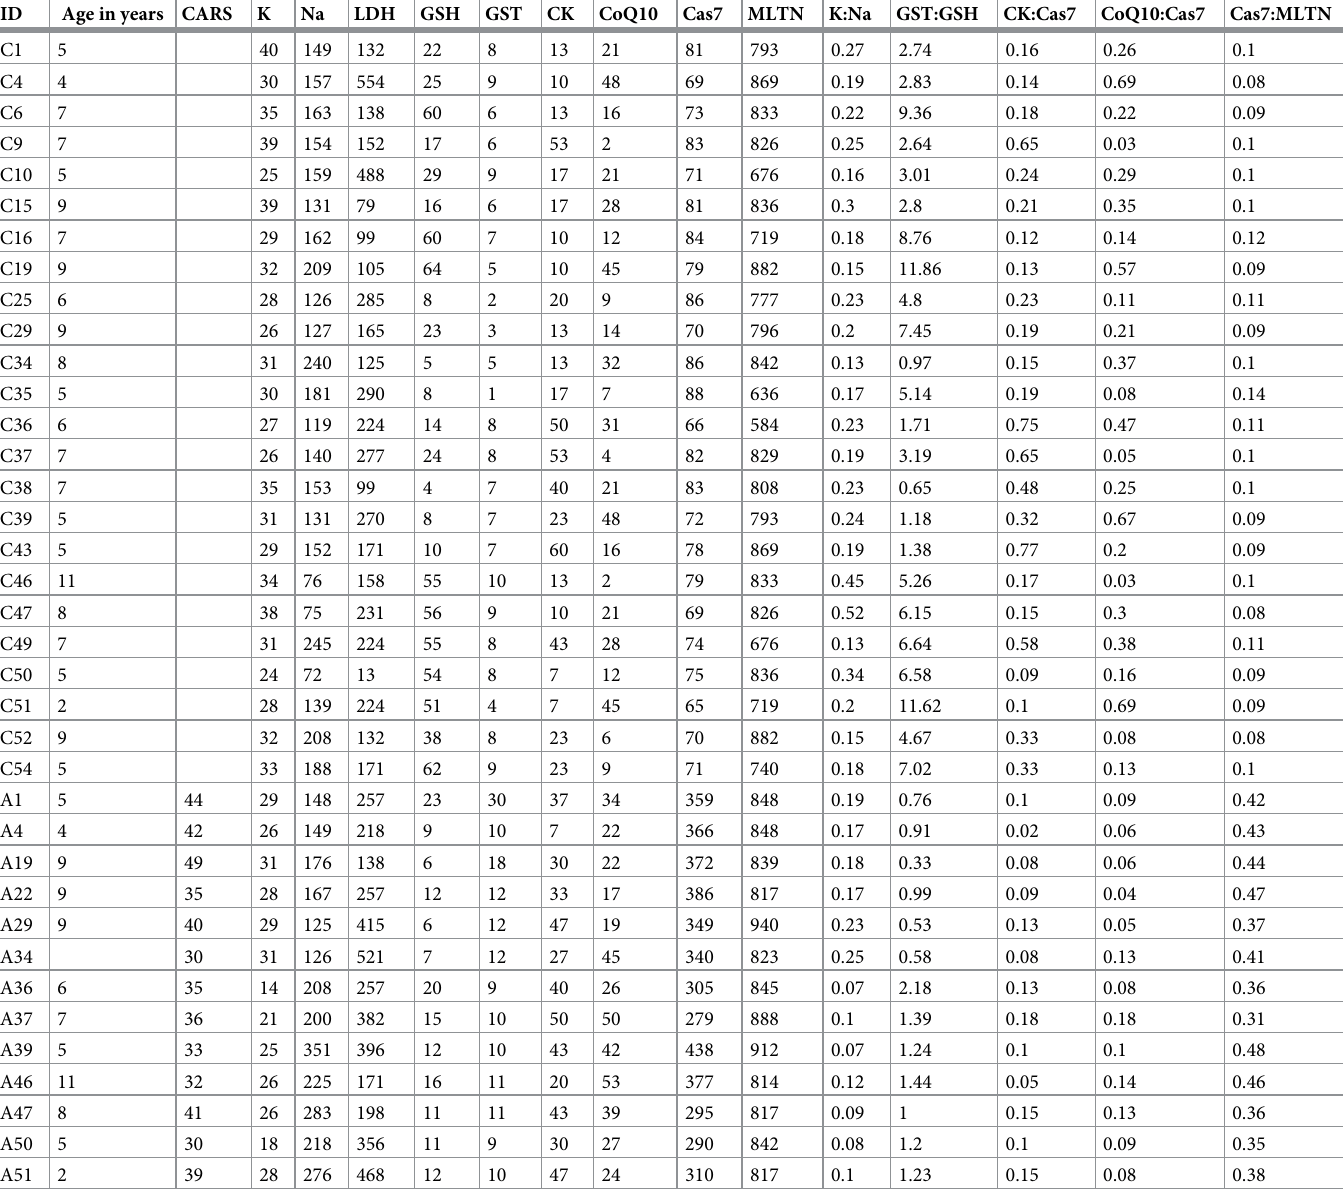
Table 1. Summary of participants’ data. Recruited volunteers included 24 healthy controls (identification numbers begin with the letter C) and 13 autistic patients (iden- tification numbers begin with the letter A). CARS: Childhood Autism Rating Scale, K: potassium (mmol/L), Na: sodium (mmol/L), LDH: lactate dehydrogenase (U/L), GSH: glutathione ( μ mol/mL/min), GST: glutathione S-transferase (U/L), CK: creatine kinase (U/L), CoQ10: co-enzyme Q10 (ng/mL), Cas7: caspase 7 (pg/mL), MLTN: melatonin